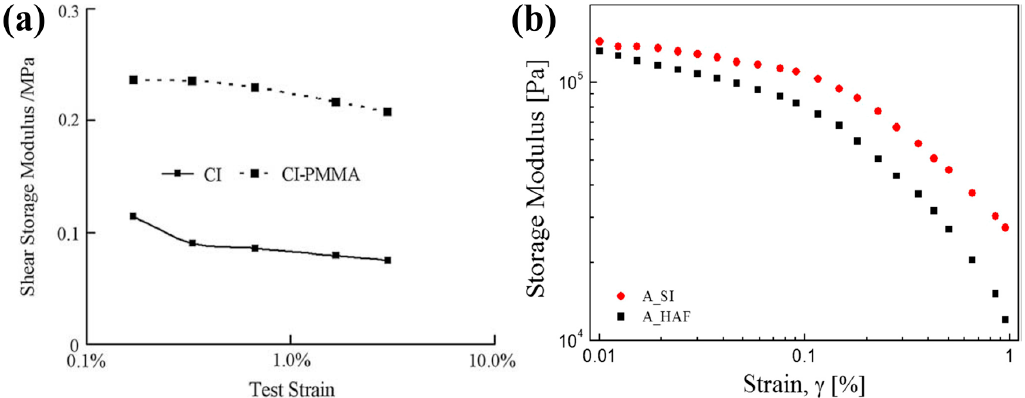
Figure 8. The storage moduli of ( a ) CI/PMMA- (dotted) and pure CI- (solid) based MR elastomers (reprinted with permission from [75], Copyright 2009 Elsevier B. V., New York, NY, USA) and ( b ) CI/APTES- (A_SI, circle) and pure CI- (A_HAF, square) based MR elastomers (reprinted with permission from [79], Copyright 2017 Elsevier B. V., New York, NY, USA).